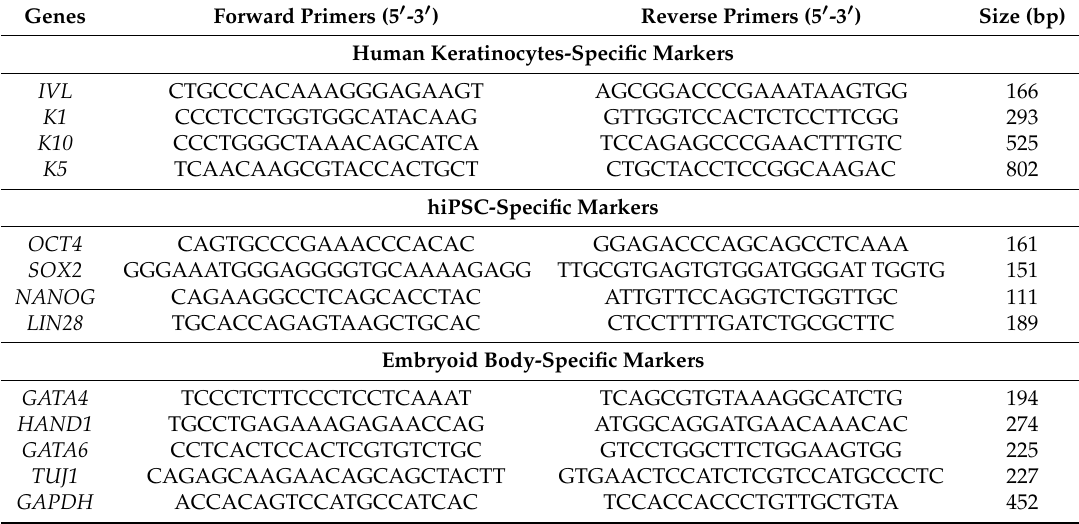
Table 2. List of primer sequences for specific